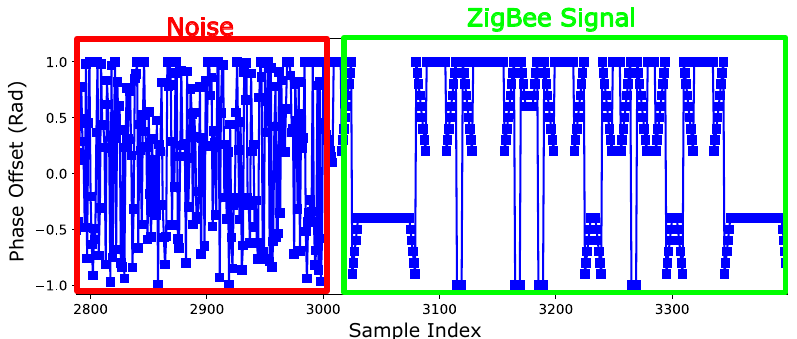
Figure 5. Illustration of how ZigBee signal is observed at WiFi Preamble Detection.